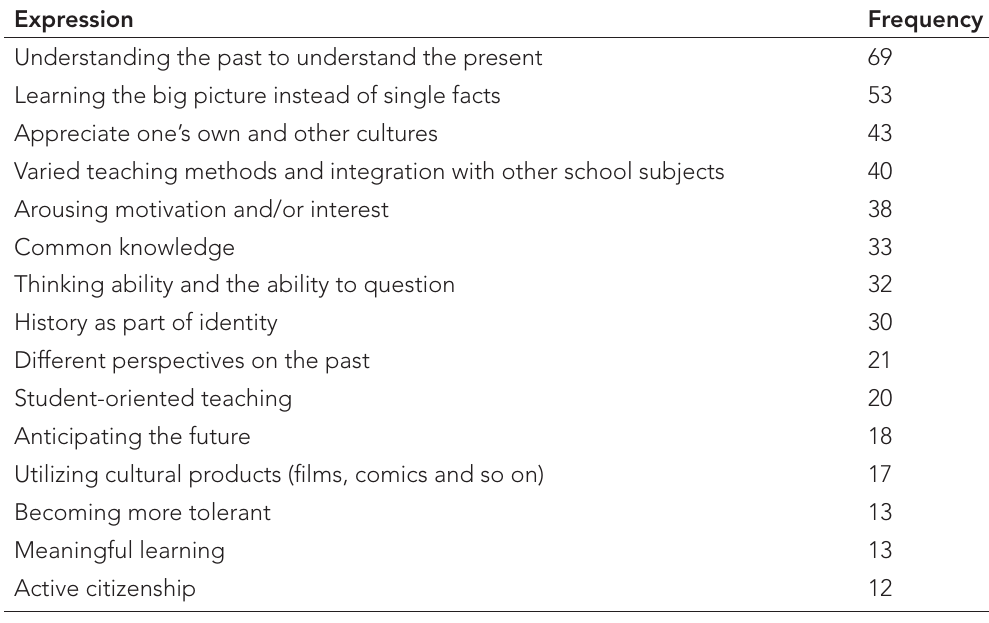
Table 1: The different expressions concerning history teaching and their frequency